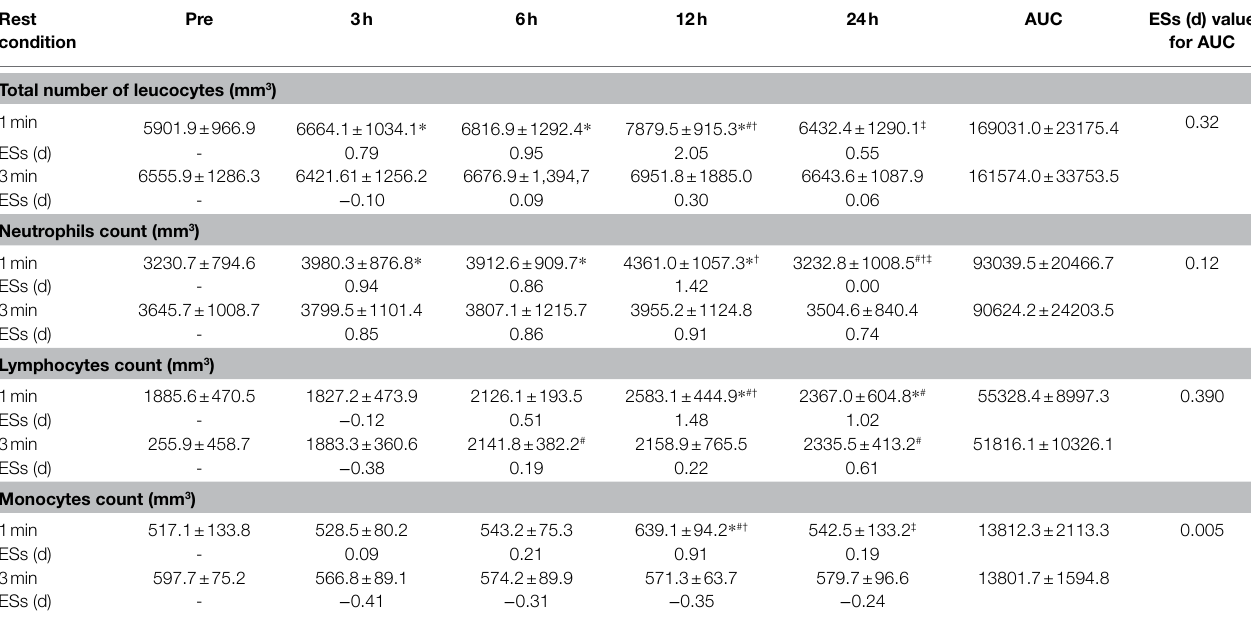
TABLE 1 | Total number of leukocytes, neutrophils, lymphocytes, monocytes area under the curve (AUC), and effect size (ESs) at pre-exercise (Pre), 3 h (3 h), 6 h (6 h), 12 h (12 h), and 24 h (24 h) after completing five sets of bench press and leg press exercises with 1- or 3-min of rest between sets. Rest